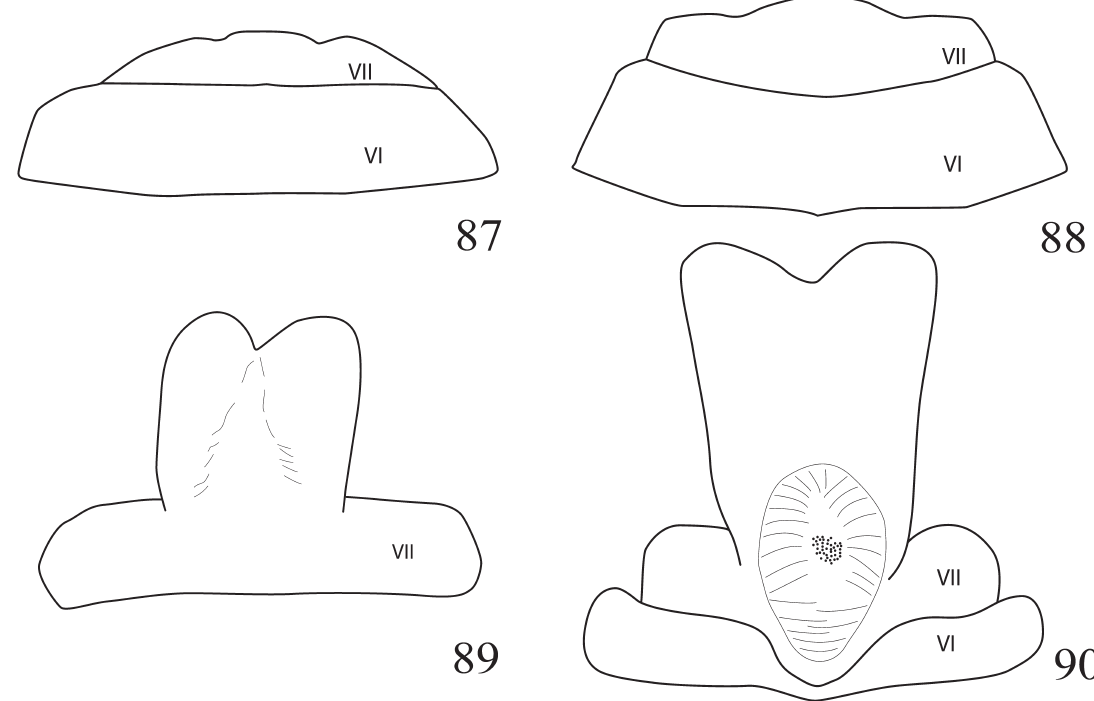
Figs 87–90. Female sternites VI and VII. 87 . Elasmoscelis fuscofasciata Stål, 1854, holotype, ♀, drawing from dry specimen. 88 . ♀ from China, Guangxi Province, drawing from dry specimen. 89 . ♀ from Thailand, Chiangmai Province prepared in glycerin. 90 . ♀ from Thailand, Na Haeo, drawing from dry